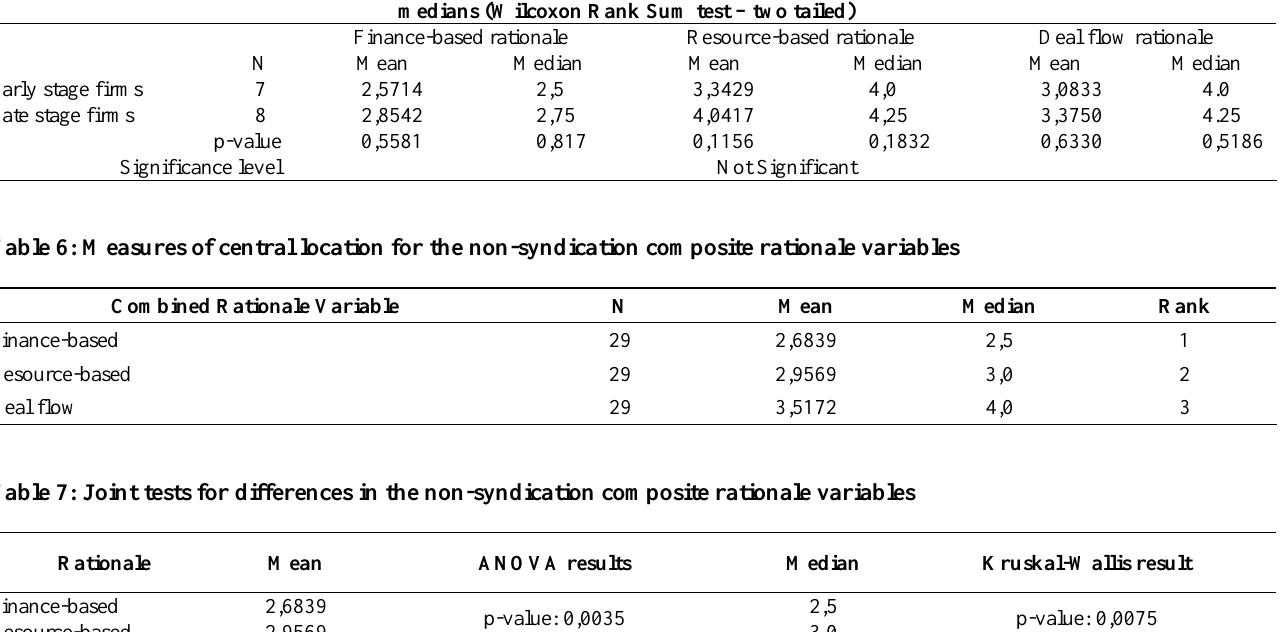
Table 5: Comparison of rationales for syndication: Early vs. Late Stage firms Comparison of rationale means (t-test assuming equal variances – two tailed) and